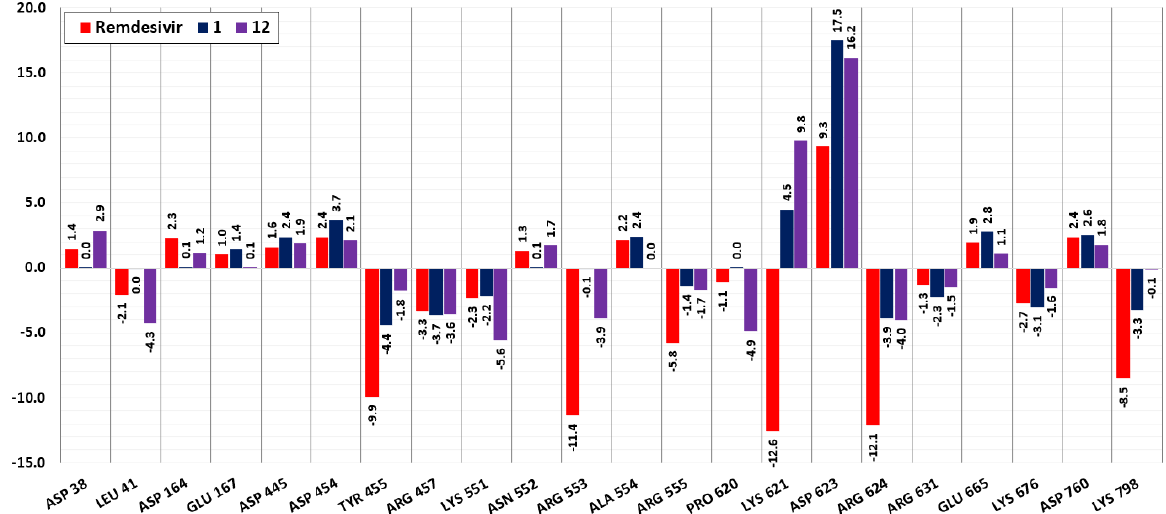
Figure 5. Total contribution energy (kJ/mol) of the commonly interacting amino acid residues of the RdRp protein for compounds 1 , 12 and remdesivir.